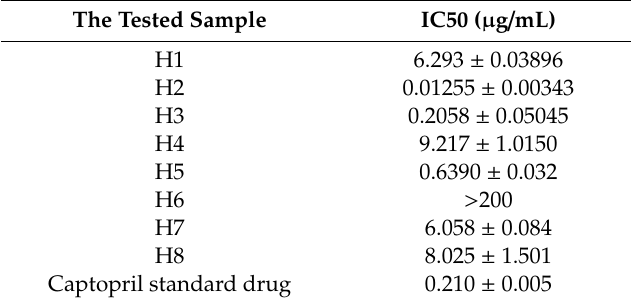
Table 1. Results of the angiotensin converting enzyme inhibition